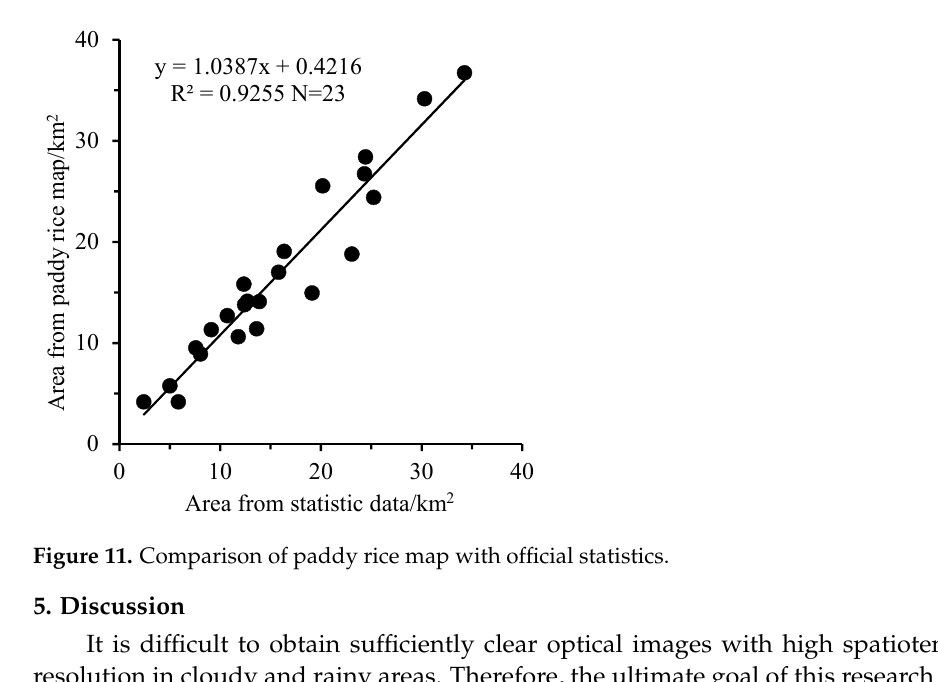
Figure 10. Spatial distribution of paddy rice fields in Yongchuan District. Subplots: ( a – f ) represent the comparison between the detail map of paddy rice extraction results and remote sensing images in six randomly selected regions.